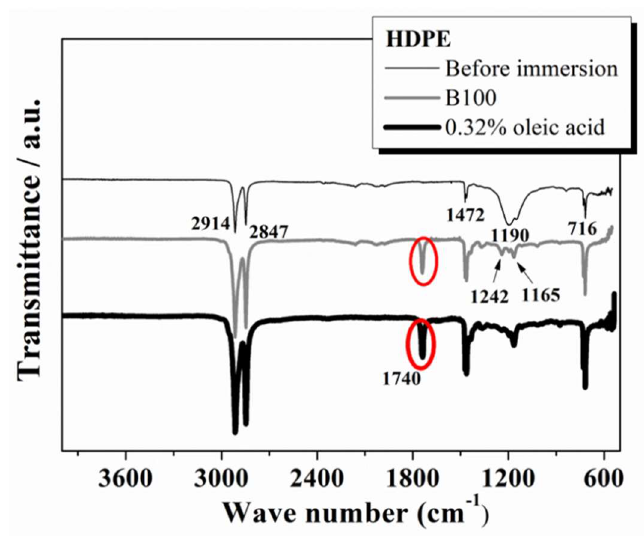
Figure 10. Fourier transform infrared (FTIR) spectra for the HDPE samples performed before and after immersion in B100 and B100–oleic acid blend.